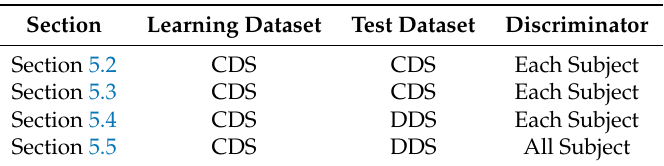
Table 2. Experimental